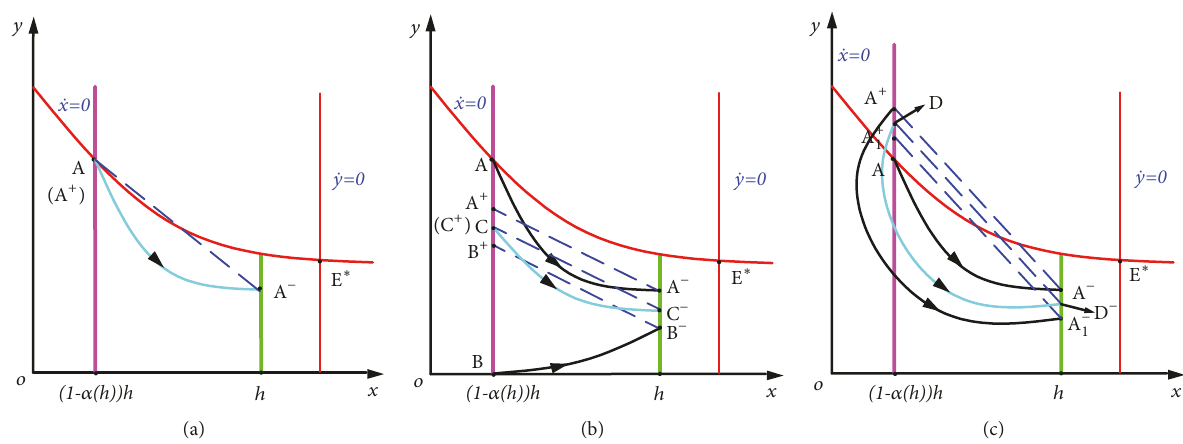
Figure 2: The existenceof the OOPS of system (7). (a) Discussion in Case (i) if 𝜎(ℎ) = 𝜎 . (b) Discussion in Case (i) if 𝜎(ℎ) < 𝜎 . (c) Discussion in Case